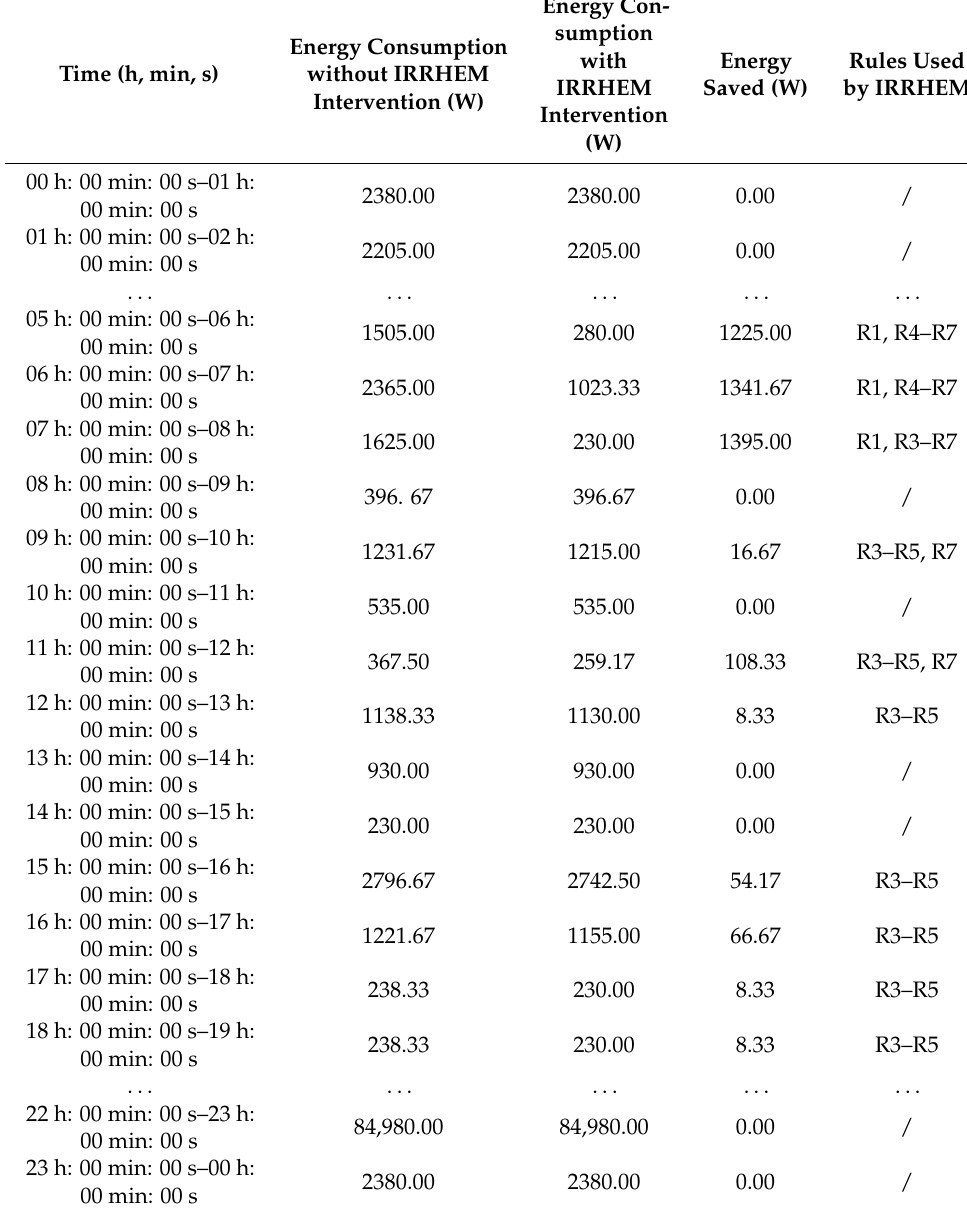
Table 9. The obtained results using IRRHEM